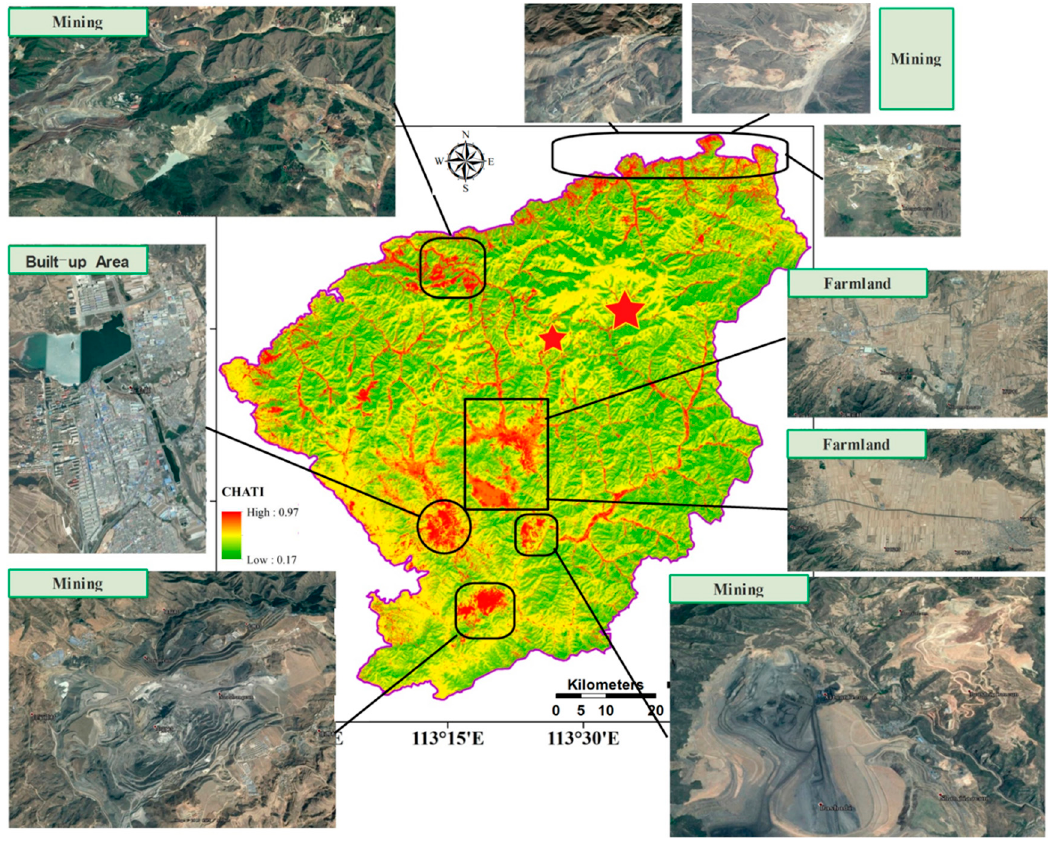
Figure 16. The threat disturbance spatial distribution based CHATI in 2018.